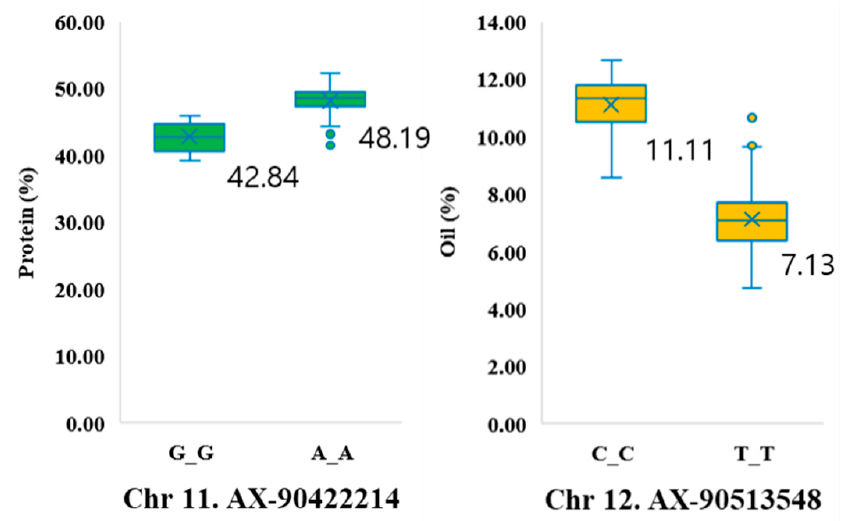
Figure 5. Phenotypic differences between lines carrying different SNP alleles associated with protein and oil content. Table 4. Significant SNP markers related to amino acid contents in the merged